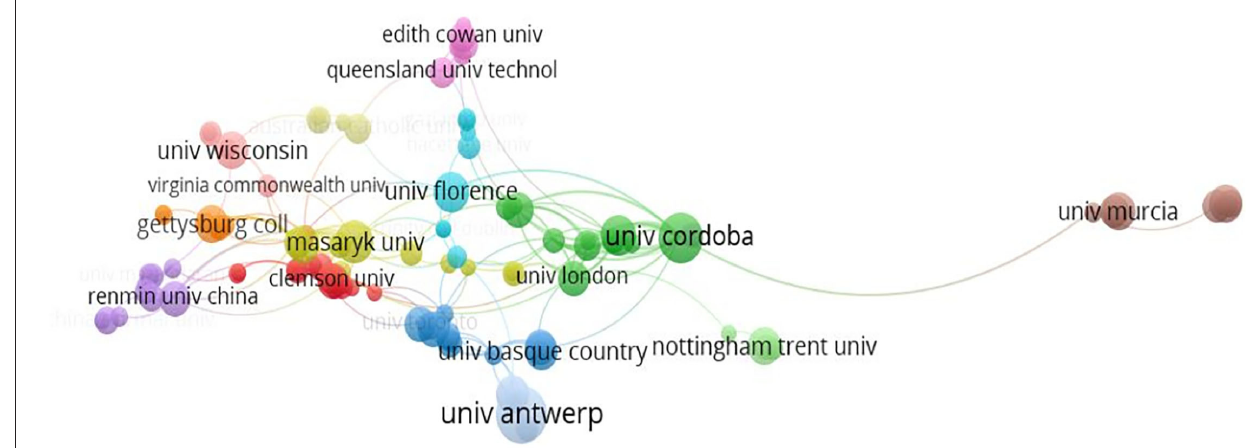
FIGURE 3 | Interagency cooperation.